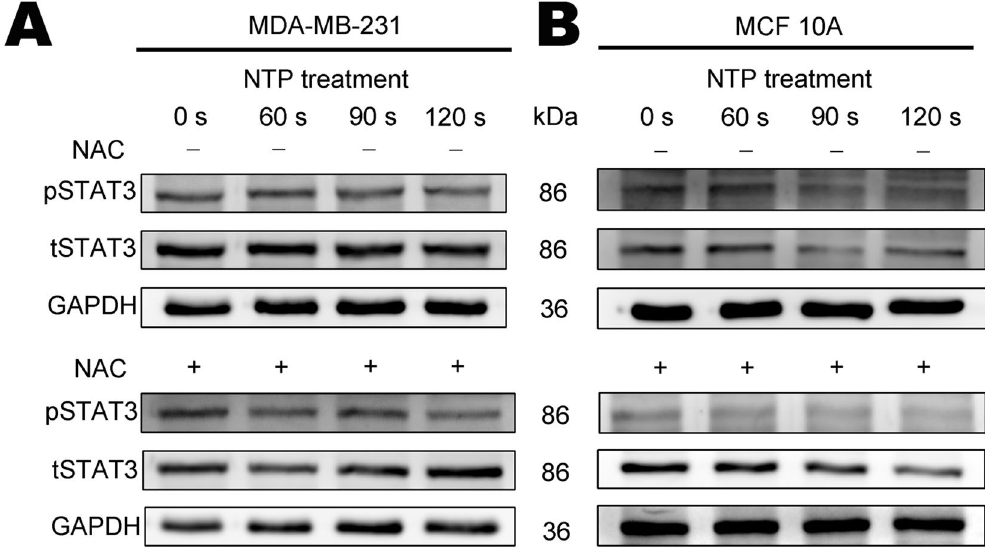
Figure 3. Effects of NTP on the expression of pSTAT3 and tSTAT3 in MDA-MB-231 and MCF10A cells. All cells were exposed to NTP for 0, 60, 90 or 120 s. After forty-eight hours post-treated with 5 mM N-acetyl cysteine (NAC + ) or without (NAC − ), proteins from total cell lysates were harvested. The expressions of pSTAT3 and STAT3 in MDA-MB-231 ( A ) and MCF10A ( B ) cells were detected by Western blot analysis. GAPDH was taken as a loading control throughout. The gels/blots were processed under the same experimental condition. Cropped gels/blots are displayed and full-length blots/gels are presented in Supplementary Figure